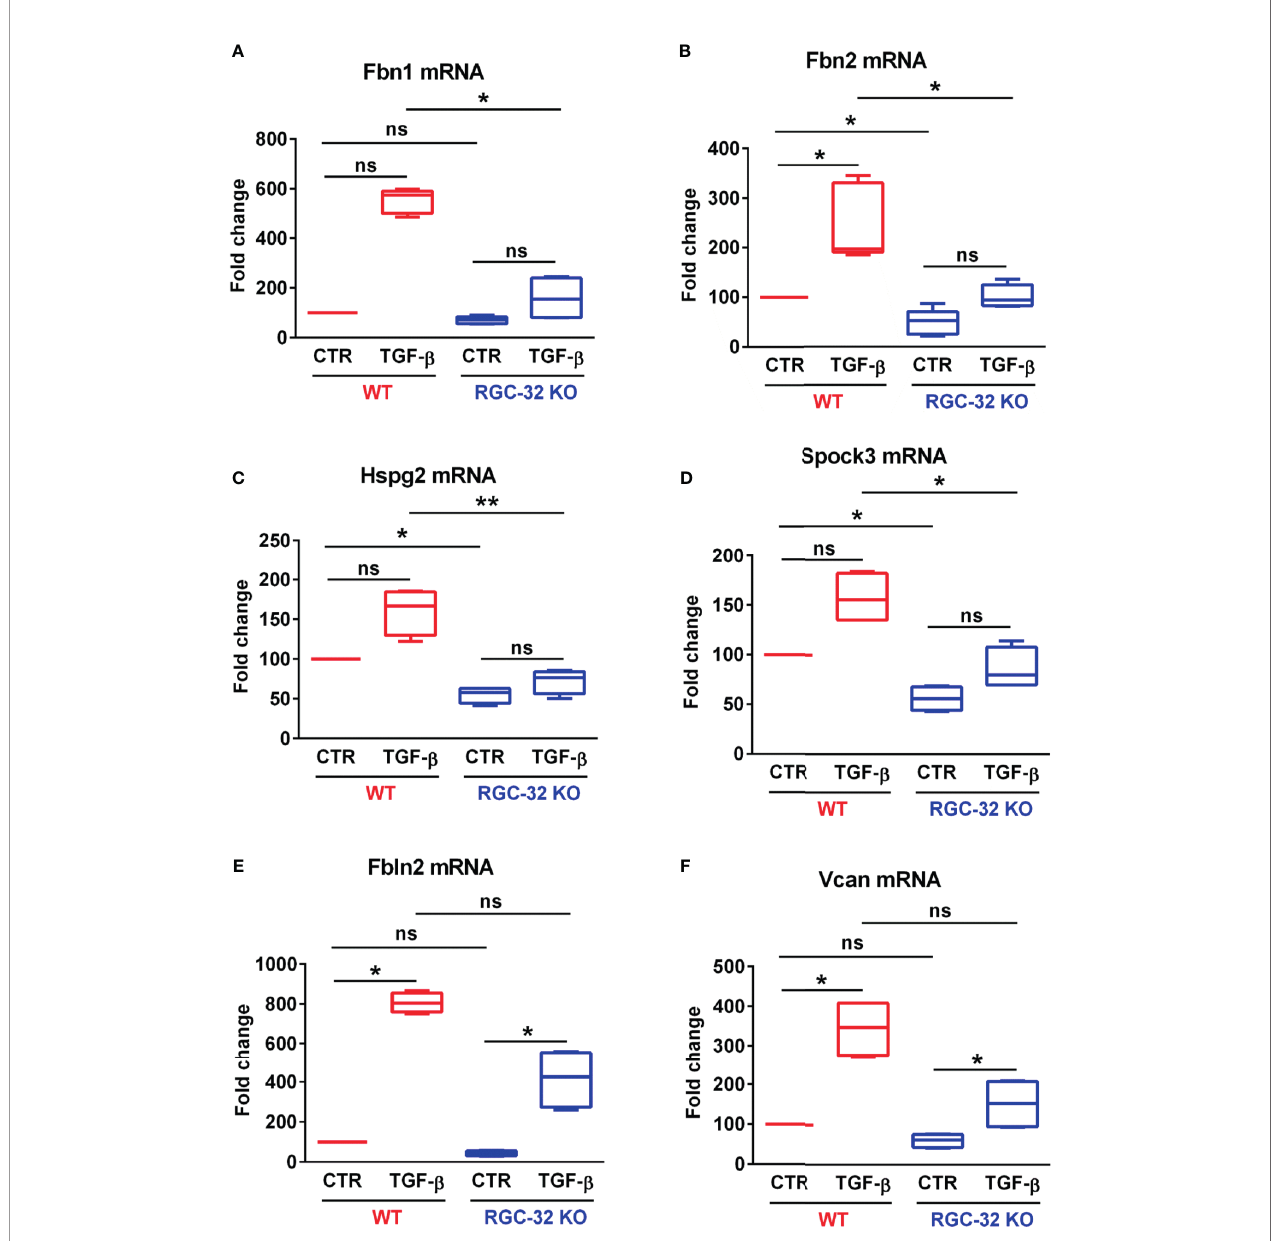
FIGURE 7 | RGC-32 facilitates the in vitro expression of genes encoding ECM-associated fi brous proteins and proteoglycan core proteins. WT and RGC-32 KO mouse astrocytes were treated with 10 ng/ml TGF- b for 24 h. The expression of Fbn1, Fbn2, Hspg2, Spock3, Fbln2 and Vcan was then assessed by Real-Time PCR. Fbn1 (A) , Fbn2 (B) , Hspg2 (C) and Spock3 (D) were signi fi cantly higher in WT astrocytes than in RGC-32 KO astrocytes after TGF- b stimulation. There were also higher stimulated levels of Fbln2 (E) and Vcan (F) in WT astrocytes than in RGC-32 KO astrocytes, although these results did not reach statistical signi fi cance. The expression of the mRNA in unstimulated (CTR) WT astrocytes was considered to be 100, and the results are shown as -fold change. Data are expressed as mean ± SEM (N = 4). *p < 0.05; **p < 0.01; ns, not statistically signi fi cant (Kruskall-Wallis test with Dunn ’ s multiple comparisons